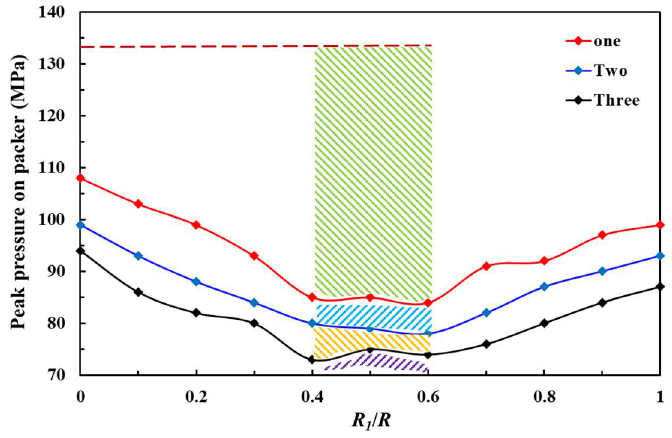
Figure 14. Perforating pressure on packer with different shock absorber installation positions.